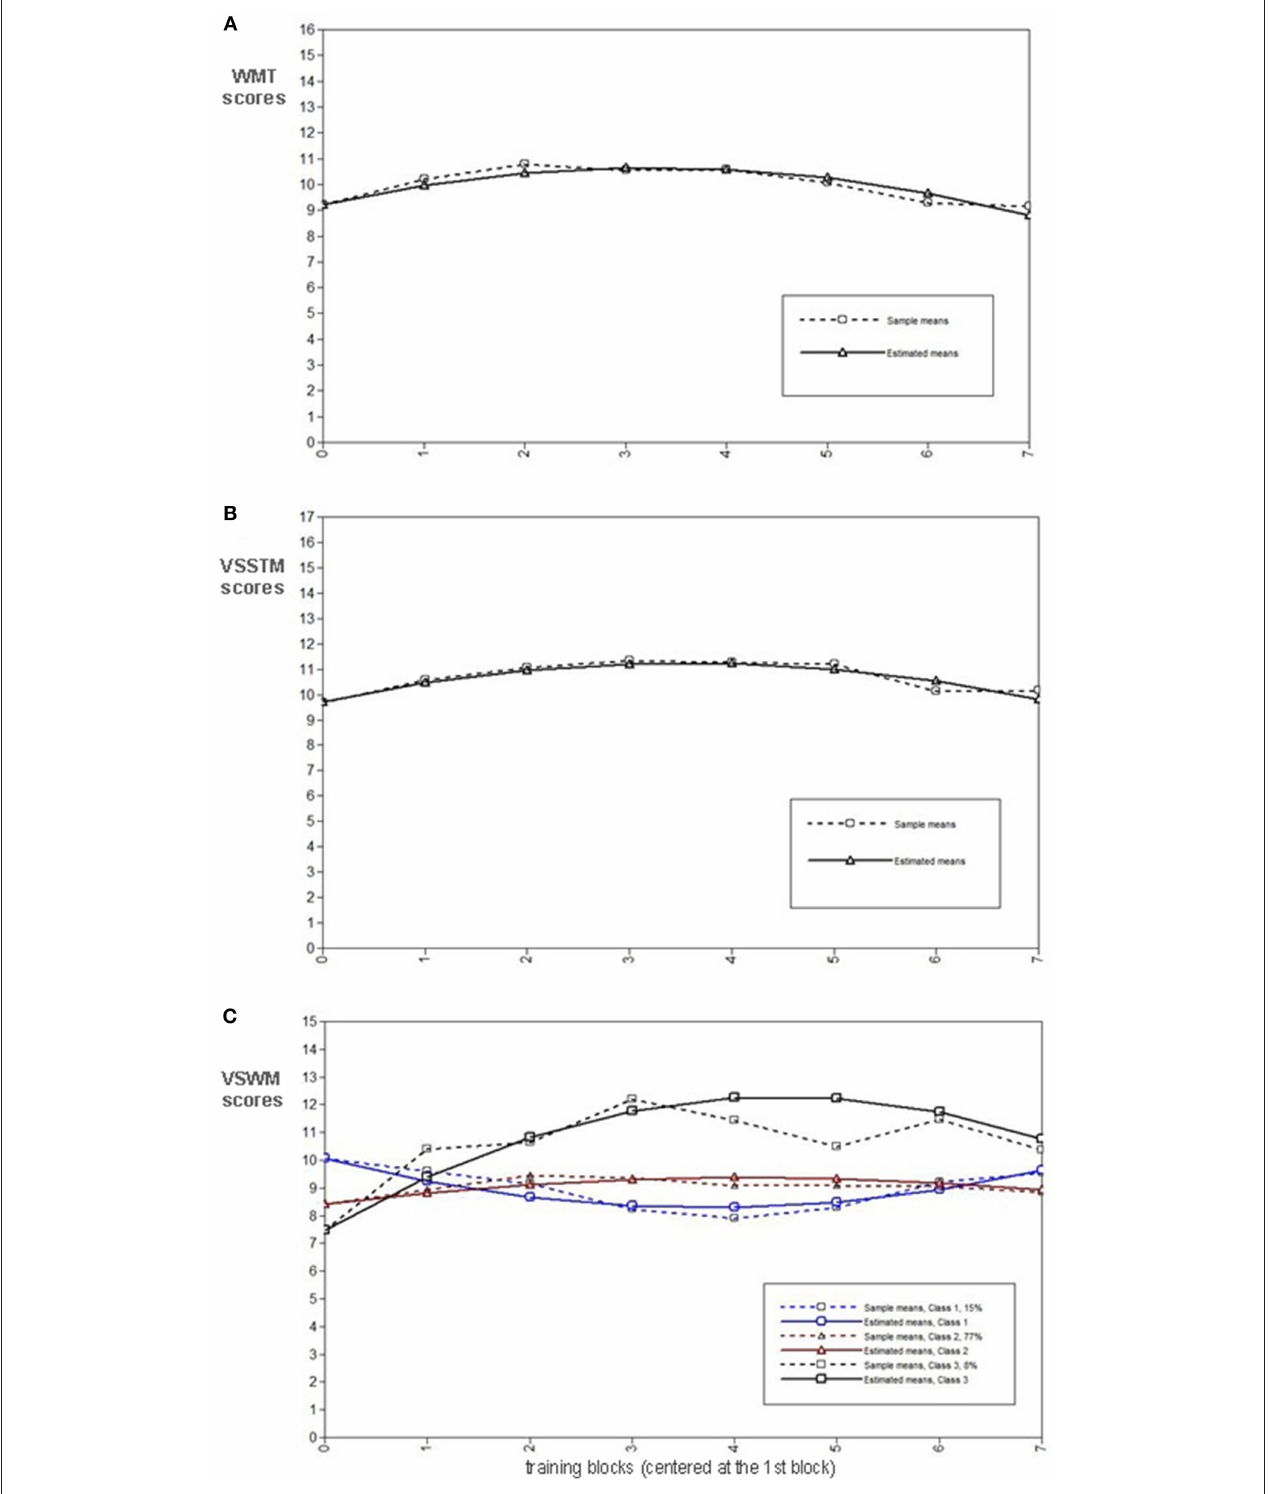
FIGURE 3 | latent learning curve over 8 blocks for all tasks in all working memory training tasks (WMT; A ), visuospatial short-term training tasks (VSSTM; B ) and visuospatial working memory training tasks (VSWM; C ) separately ( N = 90).